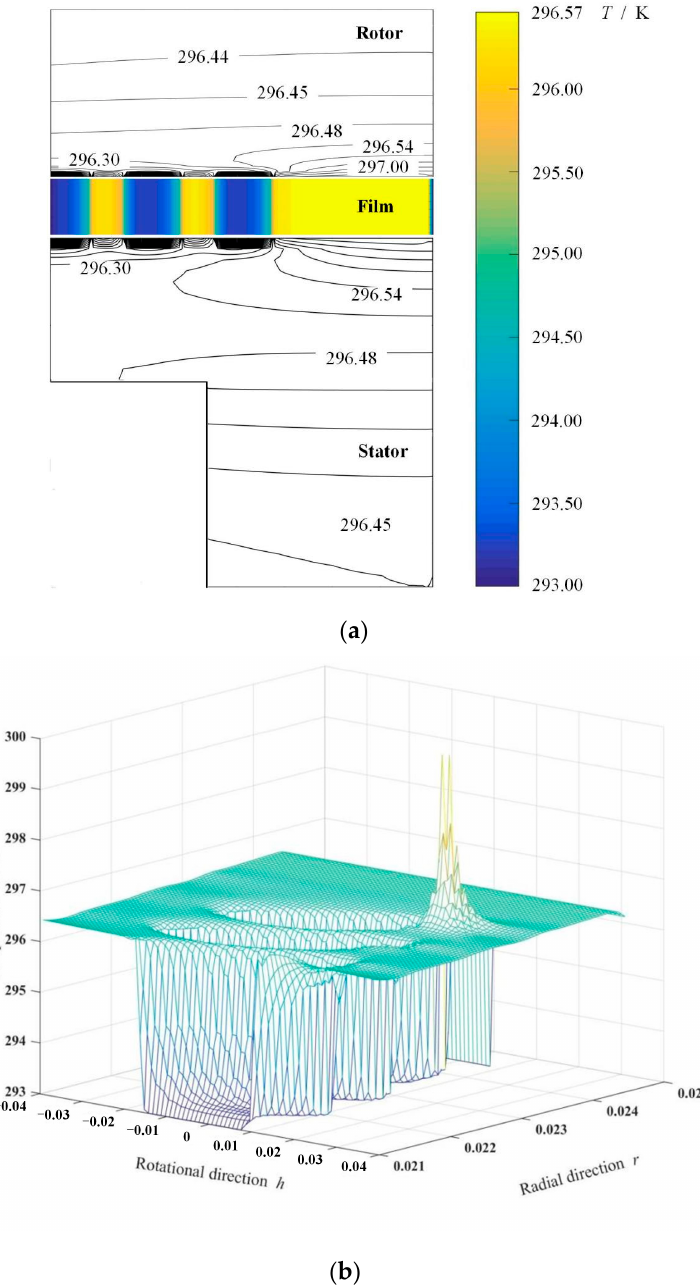
Figure 5. Cross-sectional temperature fi elds of seal and temperature isogram of sealing fi lm. ( ω = 20,000 rpm, P o = 4, h 0 = 2 μ m, h d = 5 μ m, b = 0.20 mm, γ = 3, α = 45°, N = 80). ( a ) Cross-sectional temperature fi elds of seal, ( b ) Temperature isogram of sealing fi lm.